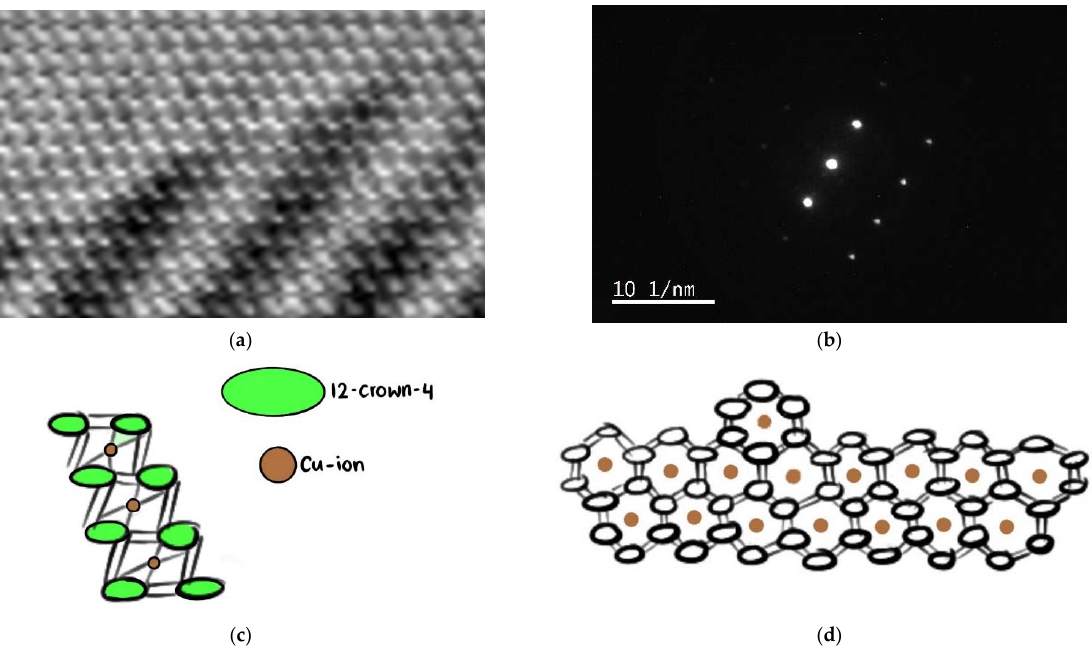
Figure 8. The transmission electron microscopy (TEM) of [Cu(12-crown-4) 2 ]I 5 : ( a ) 1274% magnifica- tion of Figure 6c; ( b ) electron diffraction pattern along lattice fringe; and illustration of structures ( c ) ribbon; ( d )